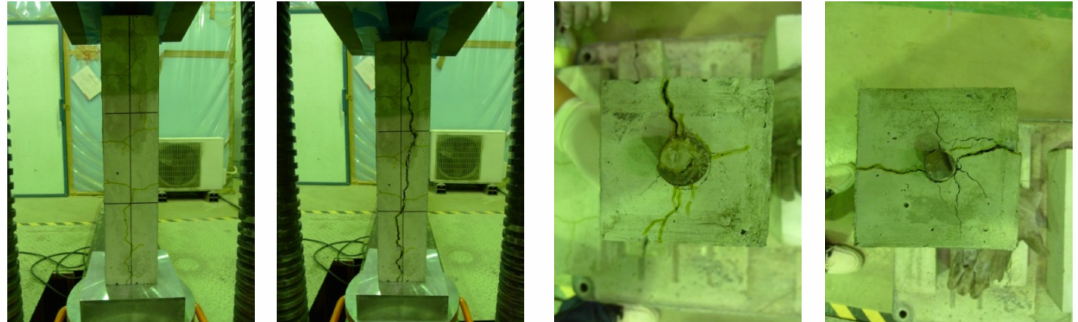
Figure 18. Rebar extraction experiment after induction